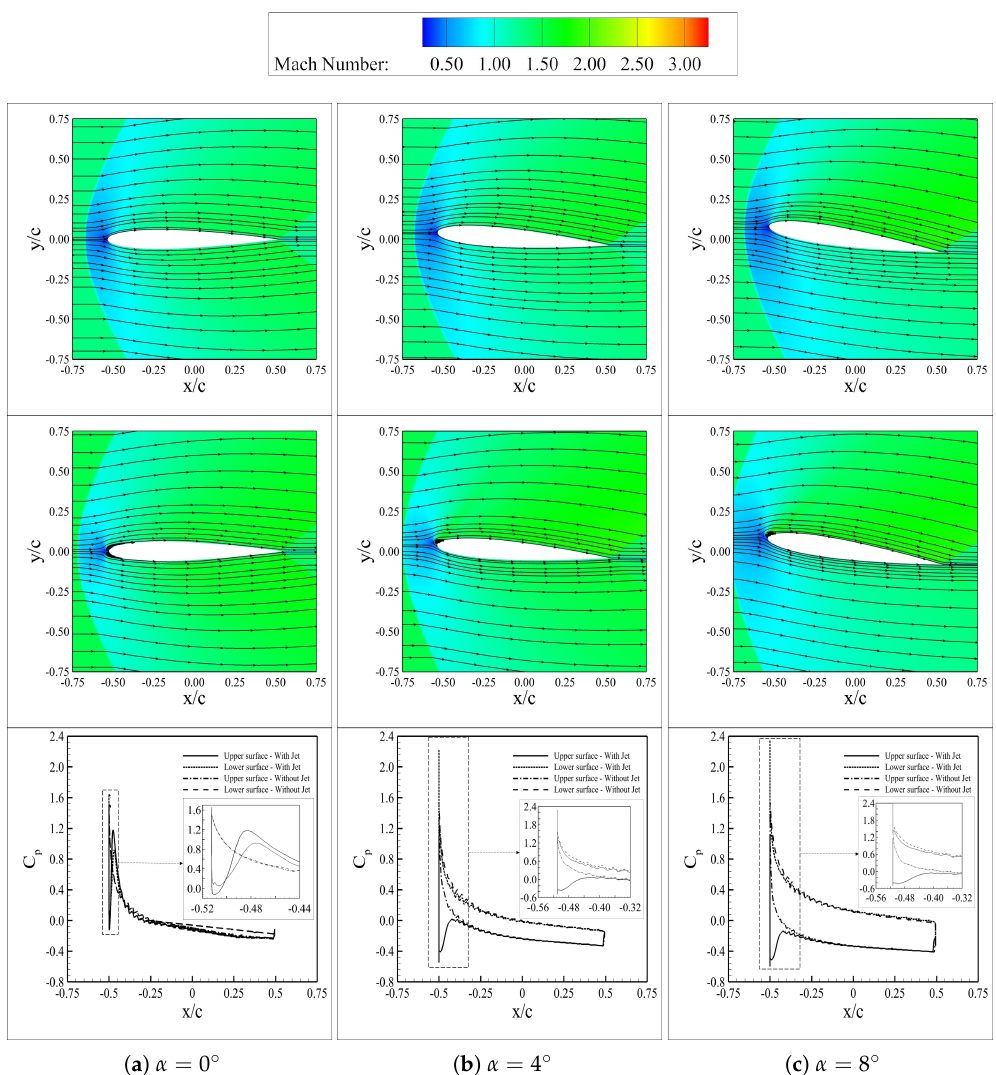
Figure 18. Variation of free stream pressure distribution by changing the airfoil angles of attack dynamically ( α = 0 ◦ to 8 ◦ ) using UDF , at constant amplitude of airfoil ( α A = 4 ◦ ) and flow mean angle of attack ( α = 4 ◦